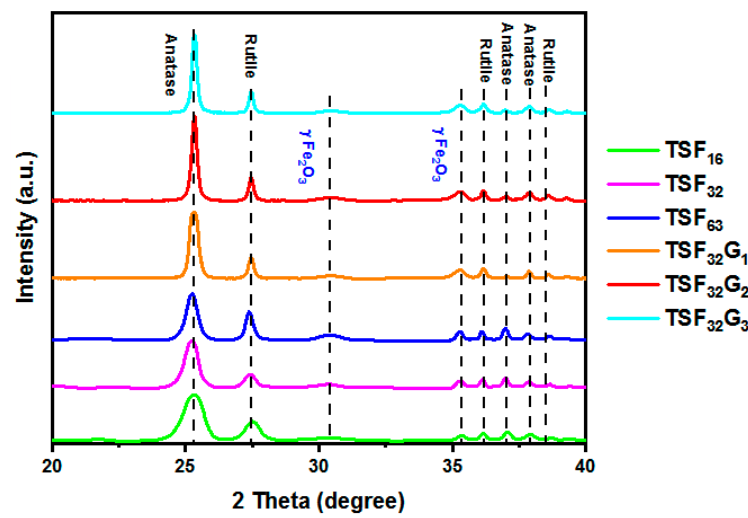
Figure 4. XRD pattern of the TSF and TSF32G coated films after heat treatment at 600 °C.